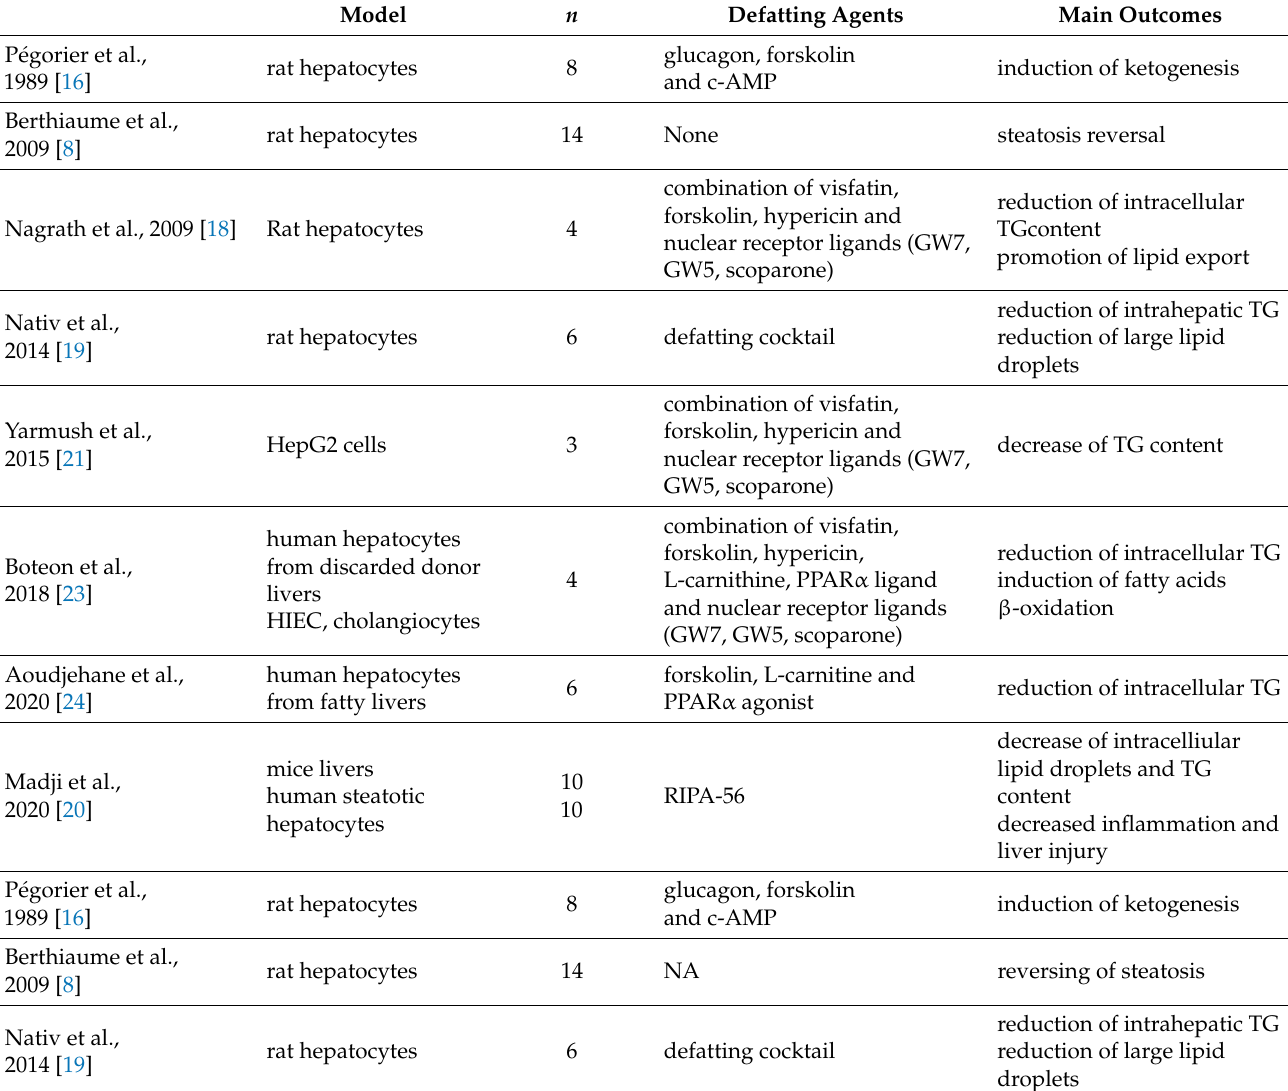
Table 1. Drugs used in in vitro models for defatting of steatotic hepatocytes. Model n Defatting Agents Main